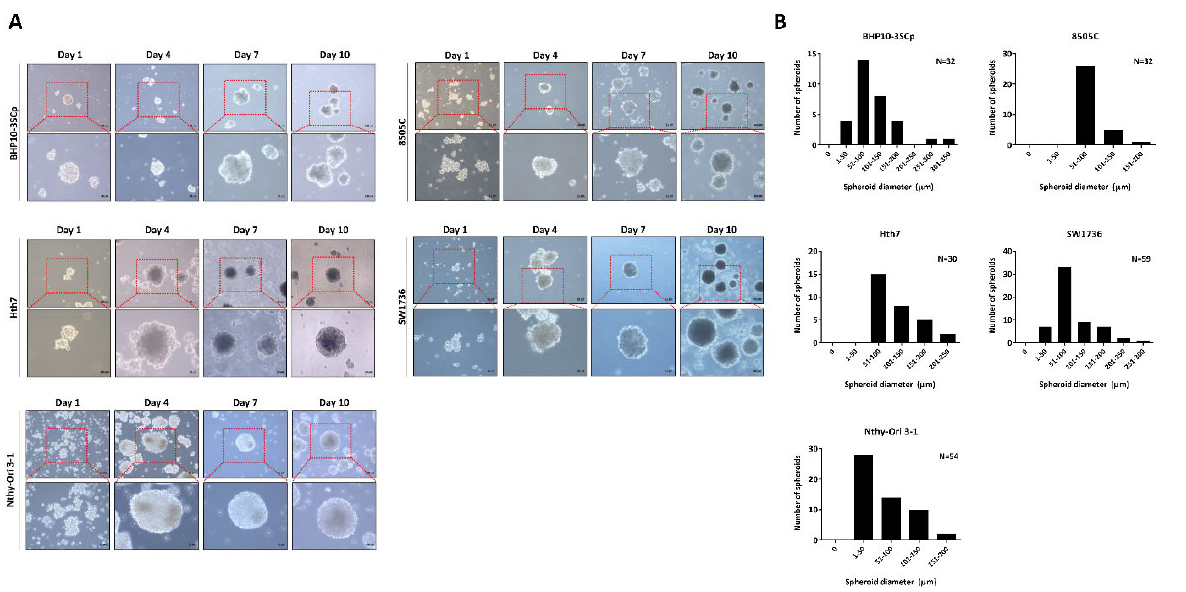
Figure 1. Establishment of 3D spheroids. Four thyroid cancer cell lines (BHP10 ‐ 3SCp, 8505C, Hth7, and SW1736) and one thyroid follicular epithelial cell line (Nthy ‐ Ori 3 ‐ 1) were well established into spheroids with cell aggregation. ( A ) Morphology of spheroids imaged via contrast microscopy every 3 days. ( B ) Size distribution of 3D spheroids on day 7. 3 days. ( B ) Size distribution of 3D spheroids on day